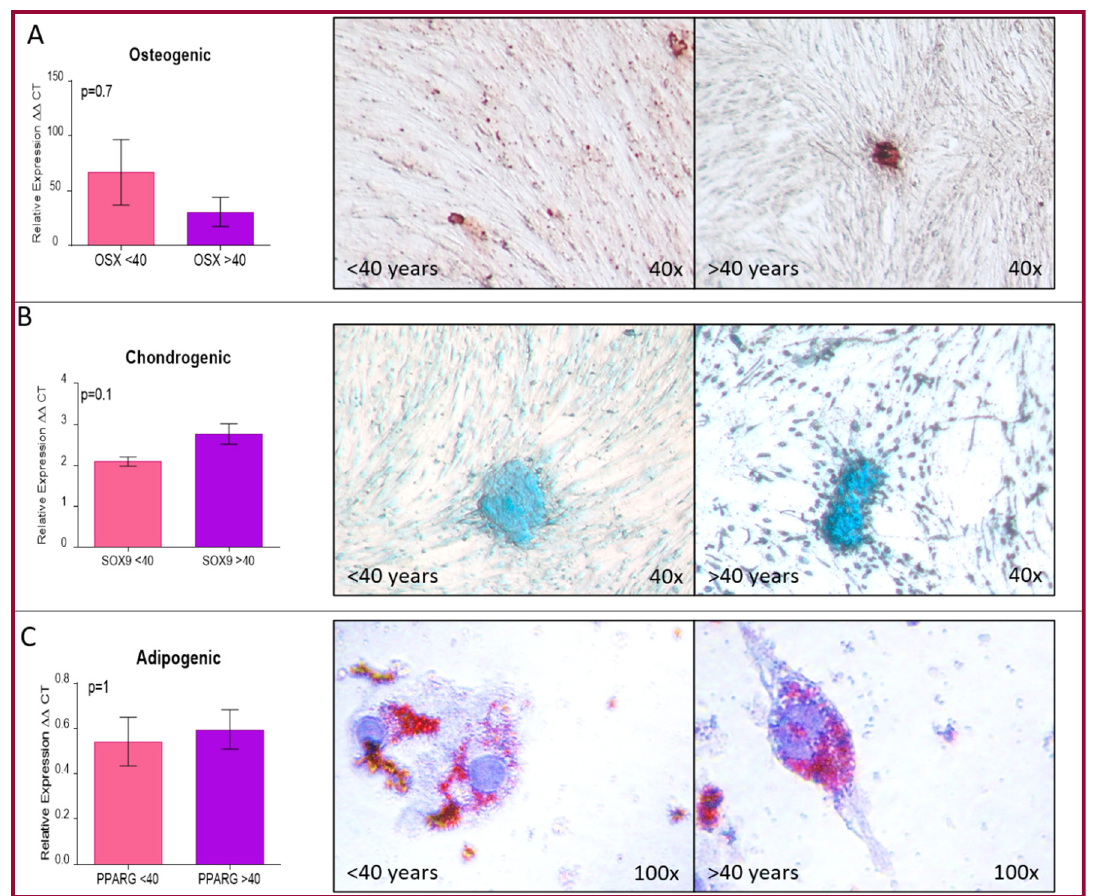
Figure 3. Comparison of hOMSC mesenchymal differentiation among age groups. ( A ) Osteogenic. Both age groups (<40 years old and >40 years old) showed an increase in OSX mRNA, a bone marker for osteoblasts as well as positive staining with alizarin red. ( B ) Chondrogenic. Both age groups (<40 years old and >40 years old) had an increased expression of Sox9 mRNA, a marker of chondrocytes and positive staining to alcian blue. ( C ) Although, there was no increase in PPAR γ mRNA, a marker of adipocyte differentiation, the cells showed lipid vesicles stained with oil red O. (Bars represent mean ± SEM), p < 0.05 was the cut off for significance, n = 3 per group).